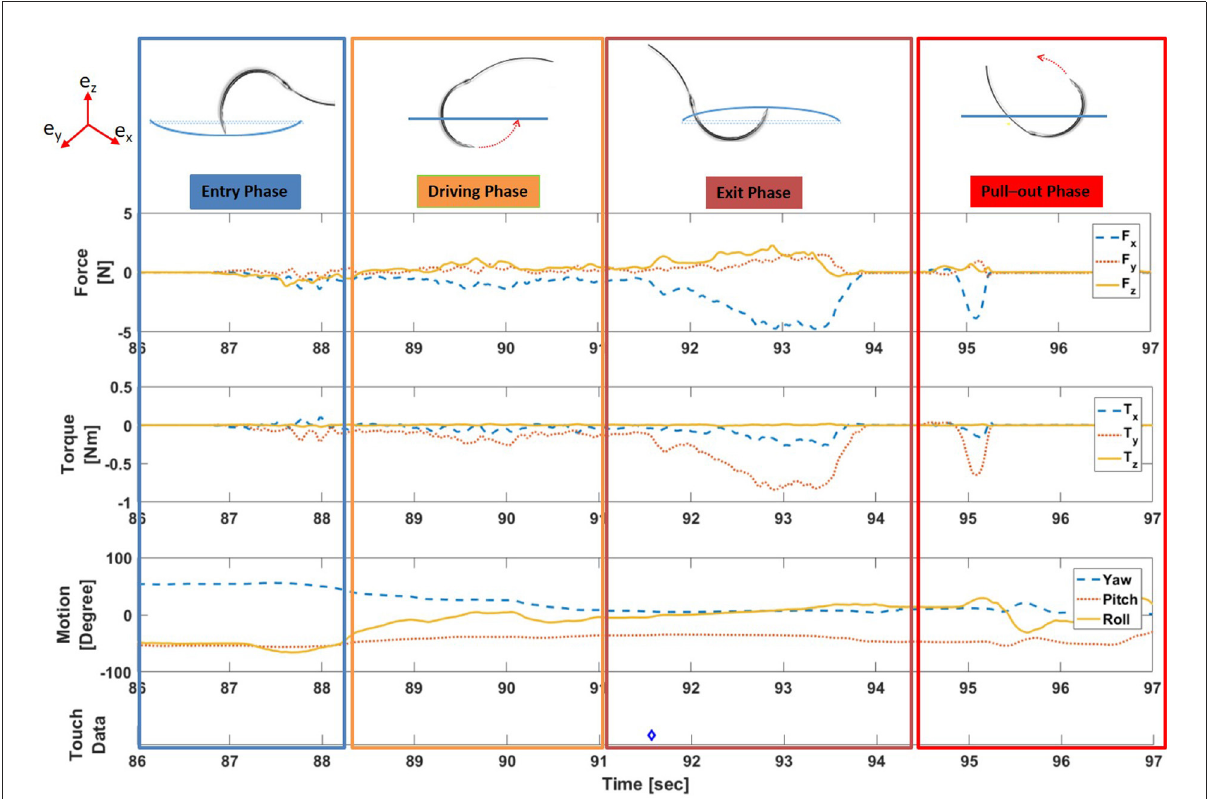
FIGURE6 Example of synchronized force, torque, motion, and touch data for one active suturing time with suture sub-events labeled. (Note: Blue diamond symbol ( ⋄ ) in touch data indicates the time instance of the physical touch).